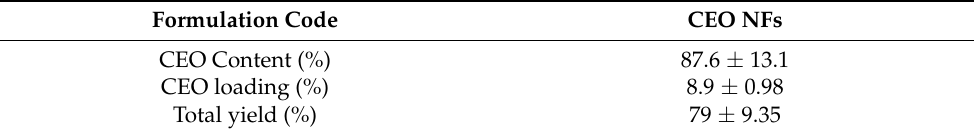
Table 3. Percentage CEO content, loading, and total yield of CEO